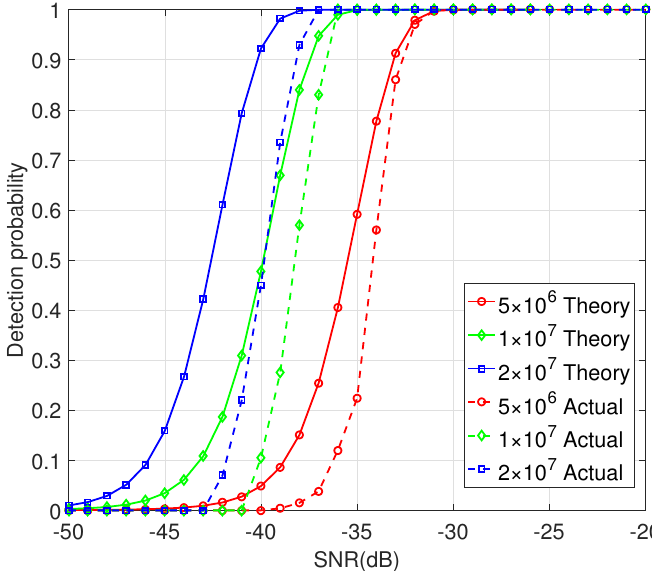
Figure 12. Sensing performance with different sampling